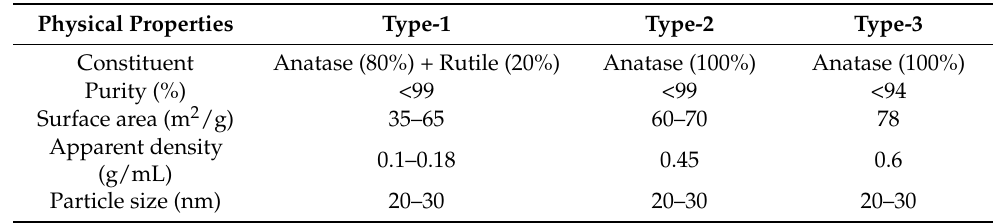
Table 1. Physical properties of TiO 2 .